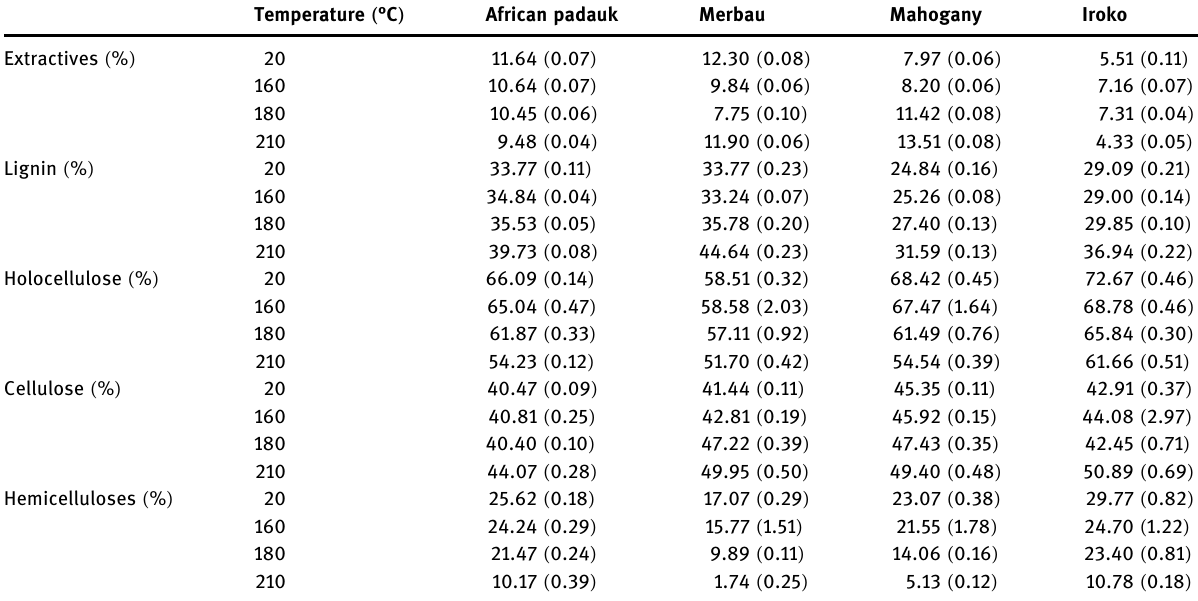
Table 1: Impact of di ff erent degrees of temperature on chemical components of wood Temperature ( °C ) African